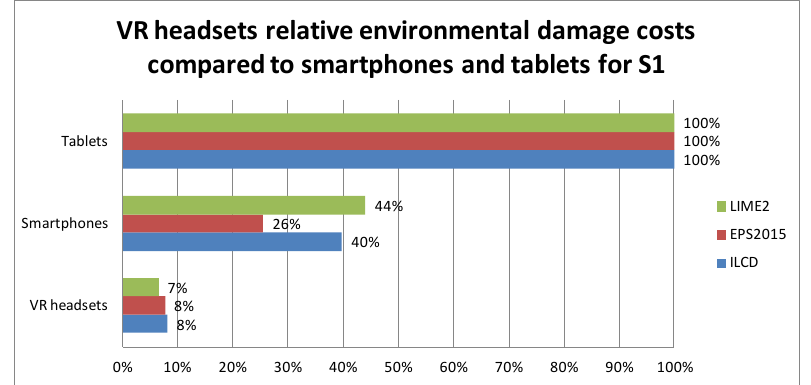
Figure 6. Relative screening LCA results for the VR headset for Scenario 1 for ILCD, EPS2015, and LIME2.